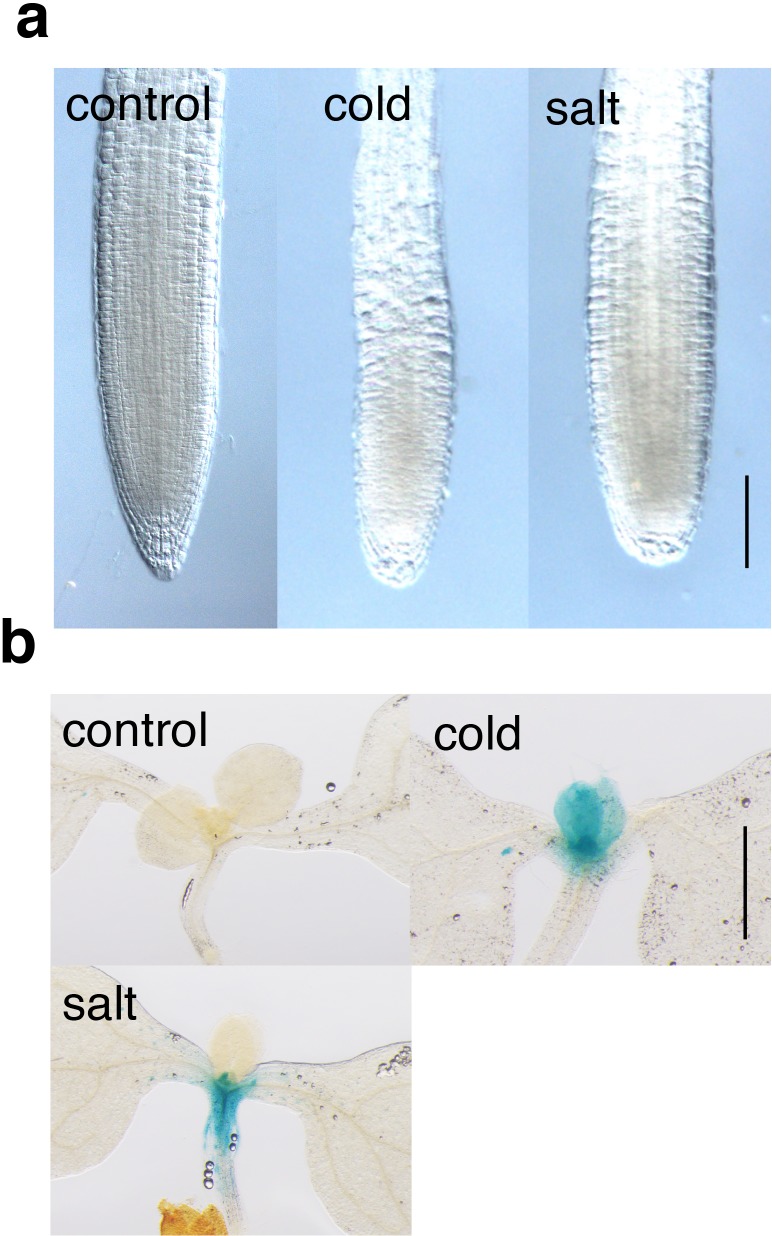
ANAC044 expression under cold and salt stresses.Five-day-old seedlings harbouring ProANAC044:GUS were incubated at 4°C (cold) or grown in medium containing 200 mM NaCl (salt) for 24 hr. After GUS staining, root tips (A) and shoot apices (B) were observed. Bars = 100 µm.